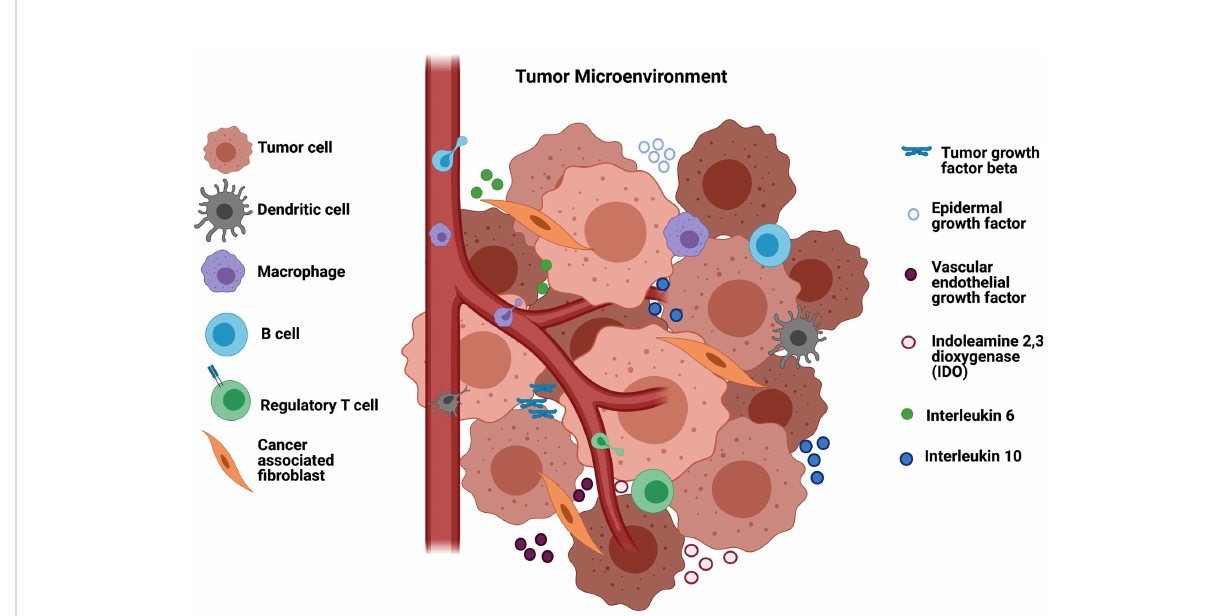
FIGURE 1 Tumor microenvironment in HNSCC and the immunosuppression. The tumor microenvironment is composed of vessels, B regulatory cells, T regulatory cells and cancer associated fi broblasts (CAF) that modulate macrophages to TAMs and suppress the in fi ltration of T lymphocytes into the TME. CAFs secrete tumor growth factor beta (TGF- b ) that suppress different immune cells as well as epidermal and endothelial growth factors that enable tumor development. Other soluble factors in the TME that mediate immunosuppression include indoleamine 2,3 dioxygenase (IDO) responsible for tryptophan depletion, interleukin 6 (I-L6) and interleukin 10 (IL-10). Figure generated using Biorender